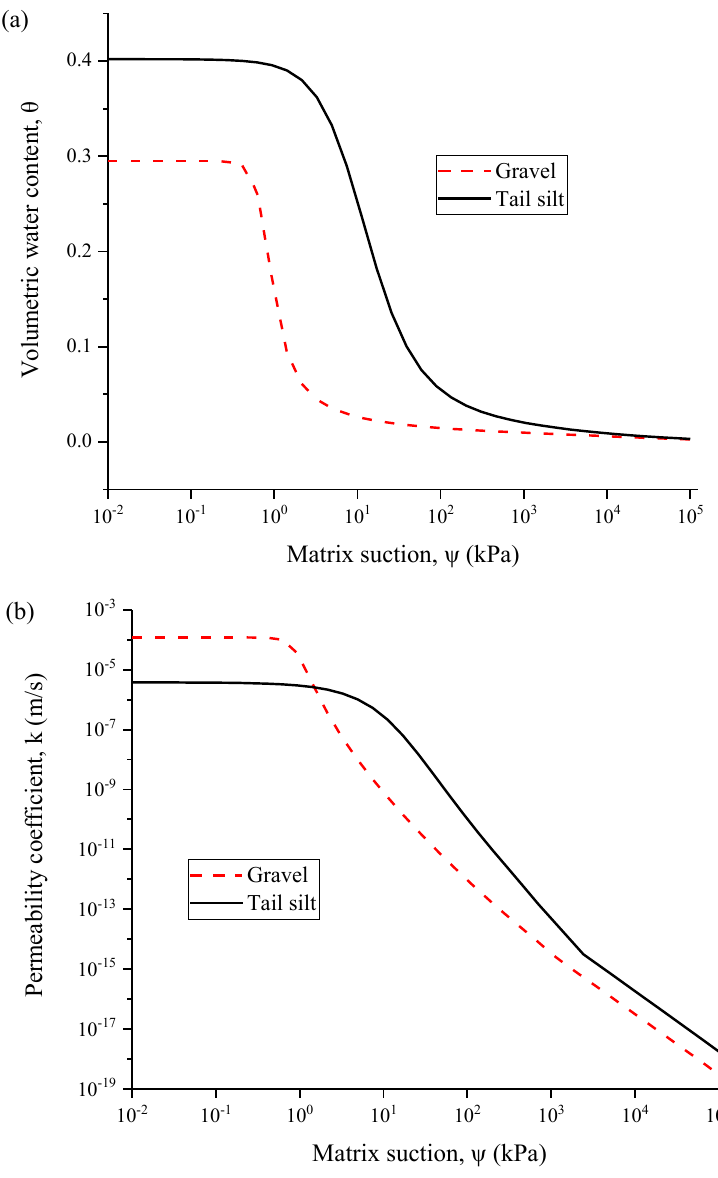
Figure 3. Parameter curves of the unsaturated soil: ( a ) soil–water characteristic curves (SWCC); ( b ) hydraulic conductivity curves.